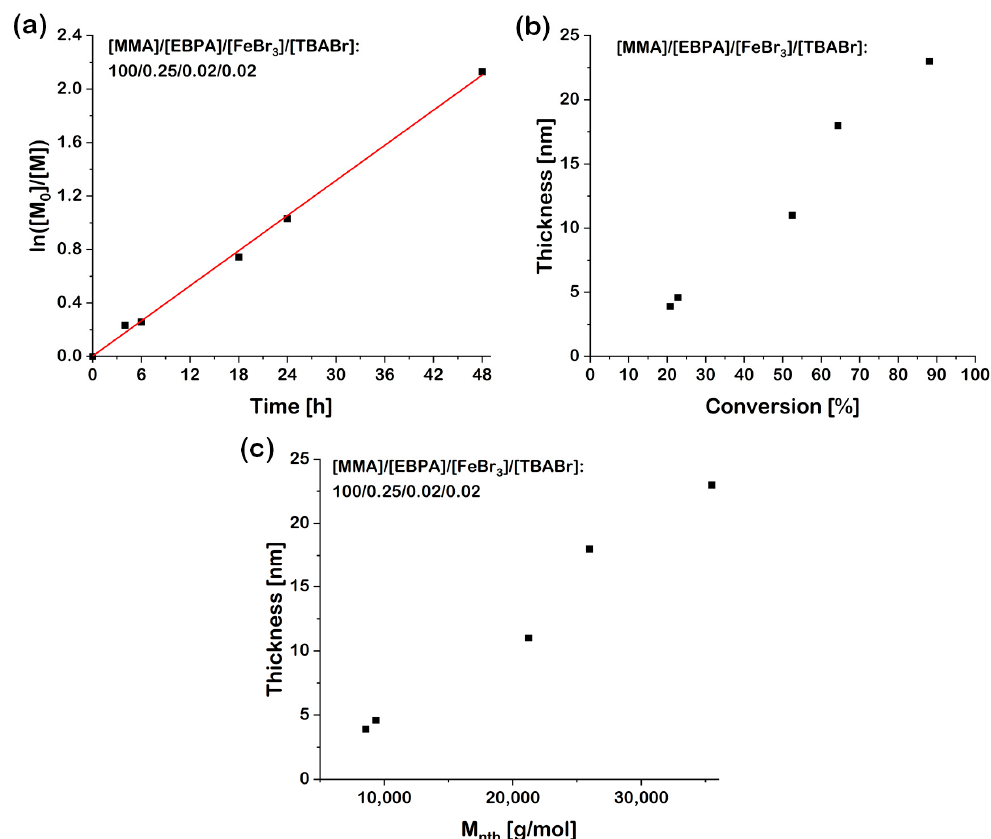
Figure 5. Results of syntheses of PMMA brushes by means of SI-photo-Fe-ATRP with sacrificial initiator: ( a ) semilogarithmic kinetic plot for synthesis of PMMA brushes (based on 1 H NMR analysis of polymerization solution after SI-photo-Fe-ATRP), ( b ) thickness vs. monomer conversion (calculated based on 1 H NMR analysis of polymerization solution after SI-photo-Fe-ATRP), and ( c ) thickness vs. theoretical number-average molecular weight.